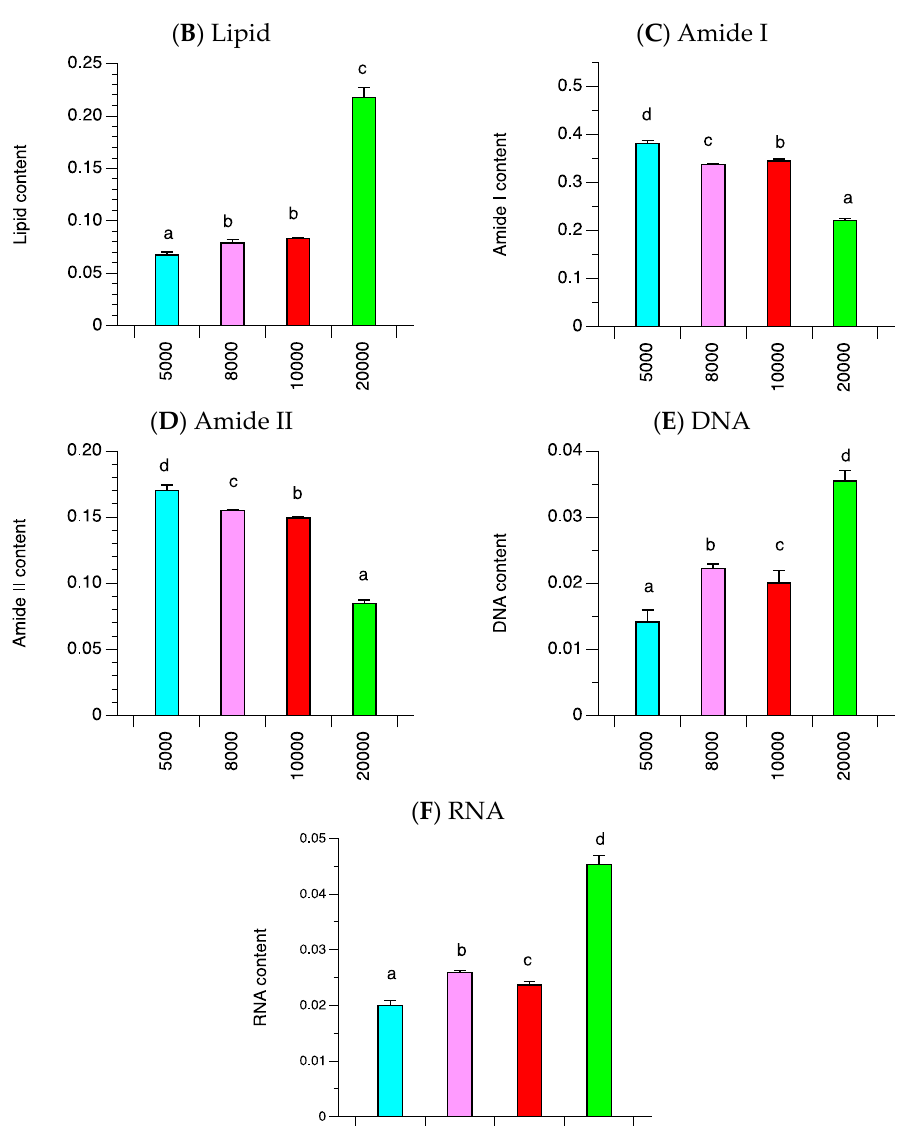
Figure 4. Fourier transform infrared (FTIR) primary spectra and integration area of cells from various spheroids. ( A ) Spheroid cells were initially seeded at various cell densities (5000 cells (solid blue line; 73 spectra), 8000 cells (purple dot-dashed line; 61 spectra), 10,000 cells (red dotted line; 60 spectra), and 20,000 cells (green dashed line; 62 spectra)). The FTIR primary spectra was divided into five spectral regions: the lipid (2813–2992 cm − 1 ), amide I (1600–1700 cm − 1 ), amide II (1480–1600 cm − 1 ), DNA (1180–1280), and RNA (1040–1140 cm − 1 ) region. The average, respective absorption spectra of each spectral region was integrated and corrected according to the total integration area, as shown in ( B – F ) for the lipid, amide I, amide II, DNA, and RNA region (n = 3). Di ff erent letters indicate a statistical di ff erence between groups ( p -value < 0.05).